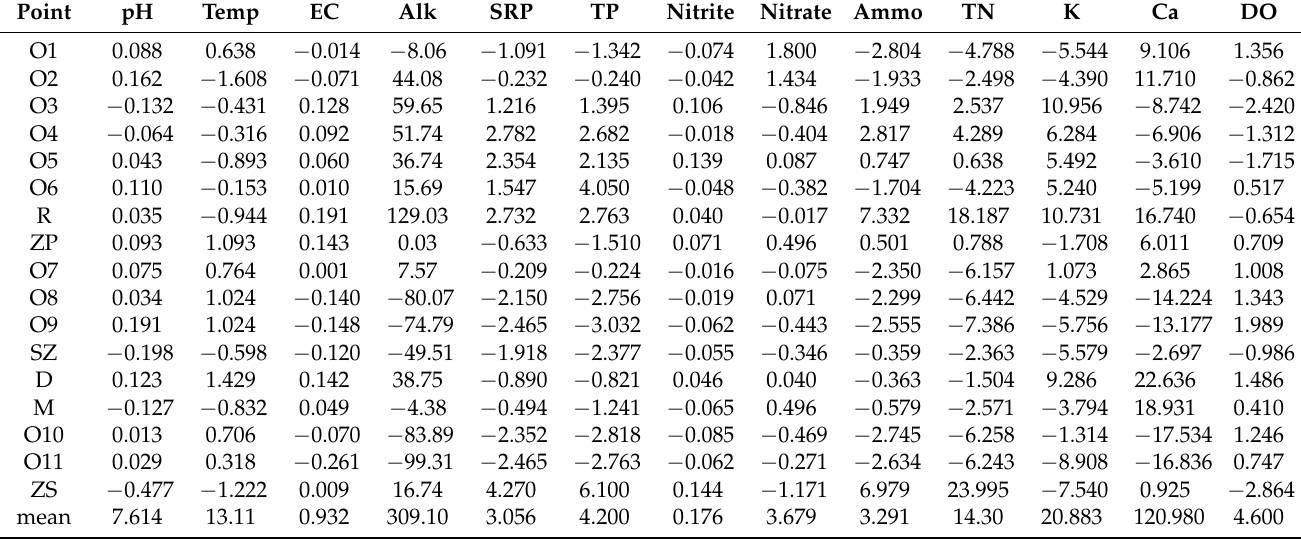
Table 4. Differences in physicochemical parameters between the mean value at individual monitoring points and the general